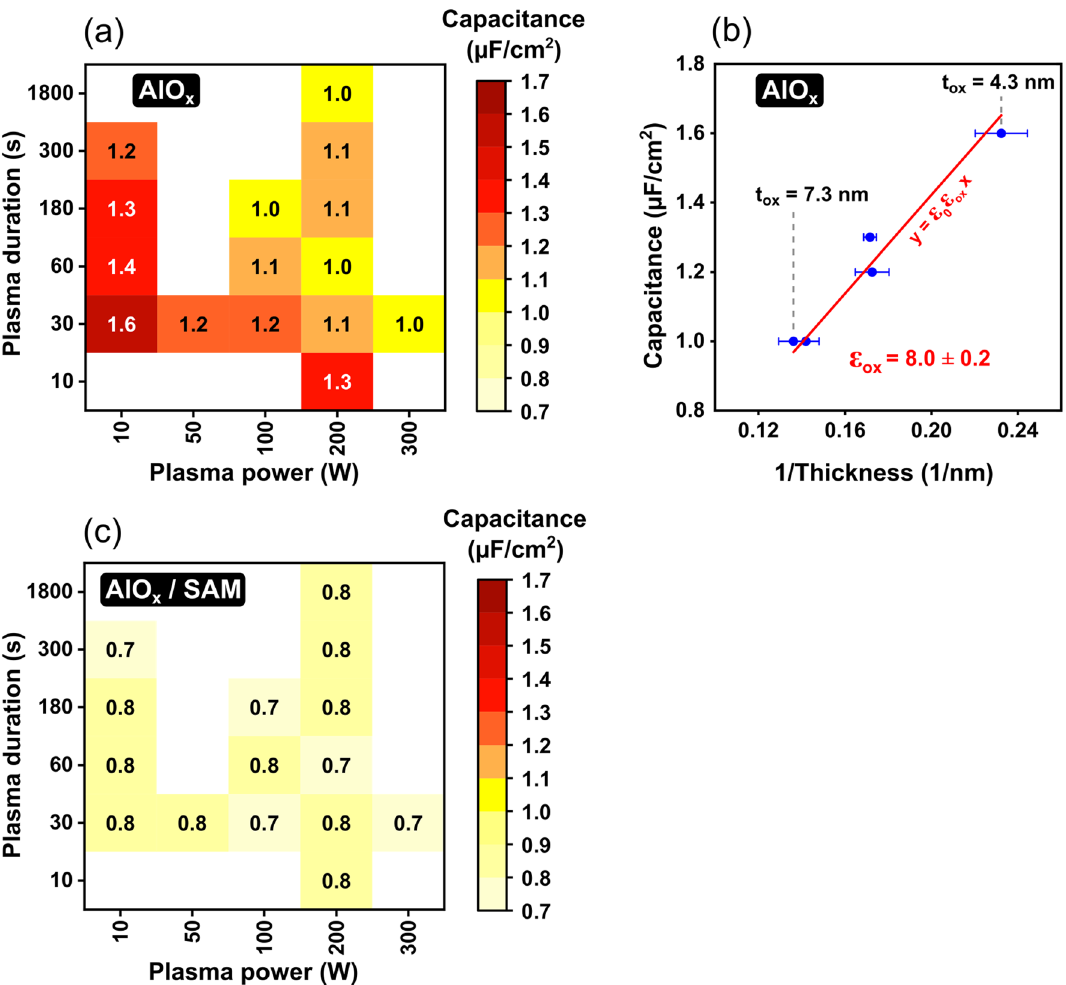
Figure 3. Capacitance of plasma-grown AlO x and hybrid AlO x /SAM dielectrics. ( a ) Measured unit-area capacitance of capacitors with a bare-AlO x dielectric as a function of plasma power and plasma duration. ( b ) Unit-area capacitance of bare-AlO x dielectrics plotted as a function of the inverse of the AlO x thickness determined by TEM (Fig. 1) to calculate the relative permittivity of the plasma-grown AlO x . The red line is a linear fit of Eq. (1) that was forced to pass through the origin (1/t ox = 0; C ox = 0). ( c ) Measured unit-area capacitance of capacitors with a hybrid AlO x /SAM dielectric as a function of plasma power and plasma